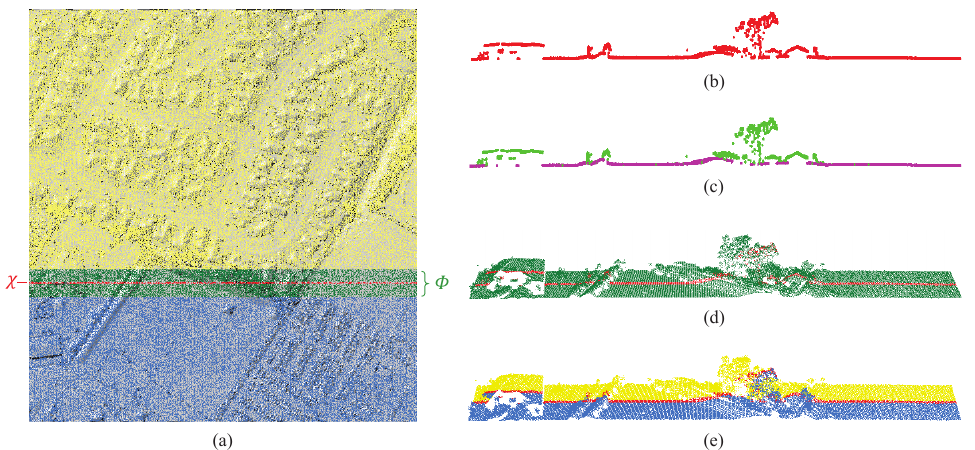
Figure 3. Illustration of Points-profile and Profile-stack: ( a ) Points-profile and Profile-stack in patch data (with DSM), where blue points denote areas that have been classified and yellow points de- note areas that have not been classified, green points denote profile-stack and red points denote points-profile; ( b ) Points-profile; ( c ) Ground truth in points-profile; ( d ) Profile-stack; ( e ) Profile-stack containing both classified and unclassified areas.